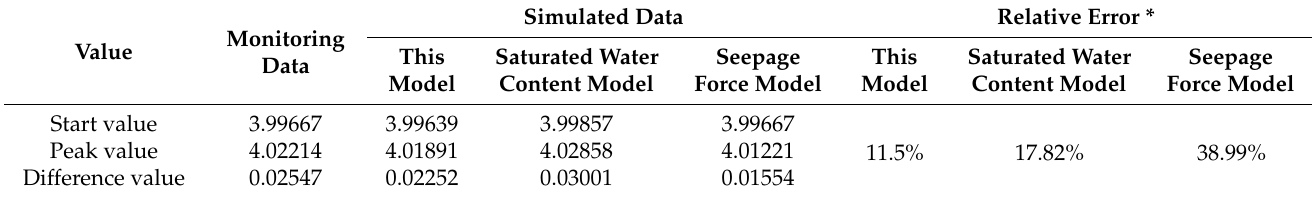
Table 3. Summary of soil pressure results simulated by three